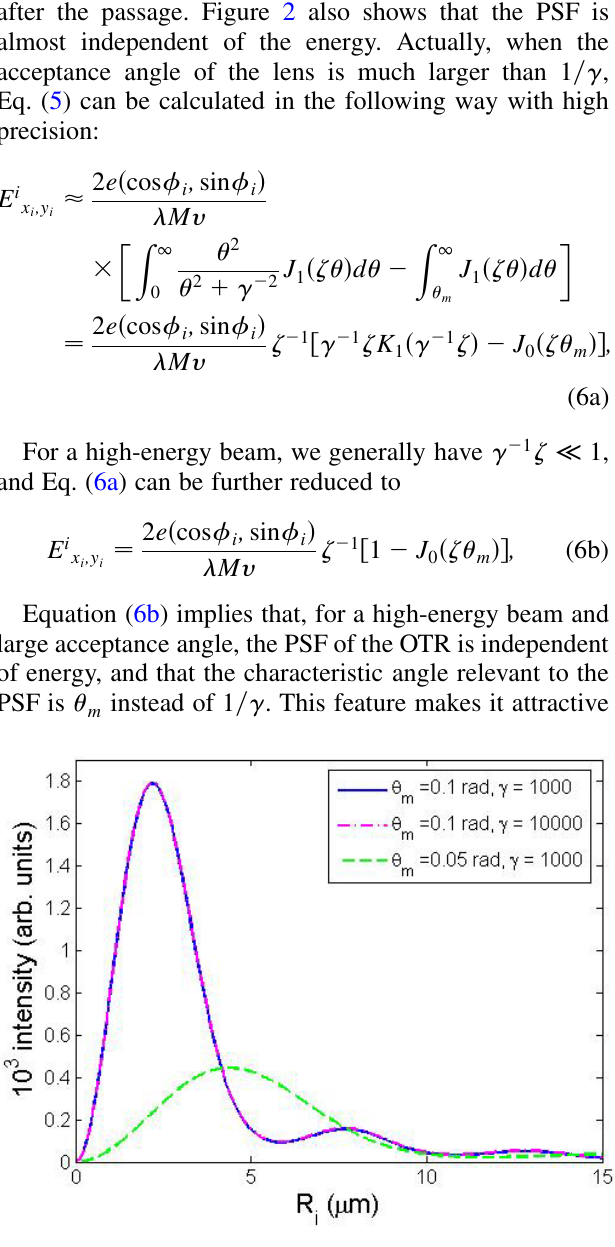
FIG. 2. (Color) PSF of the OTR for various beam energies and various lens acceptance